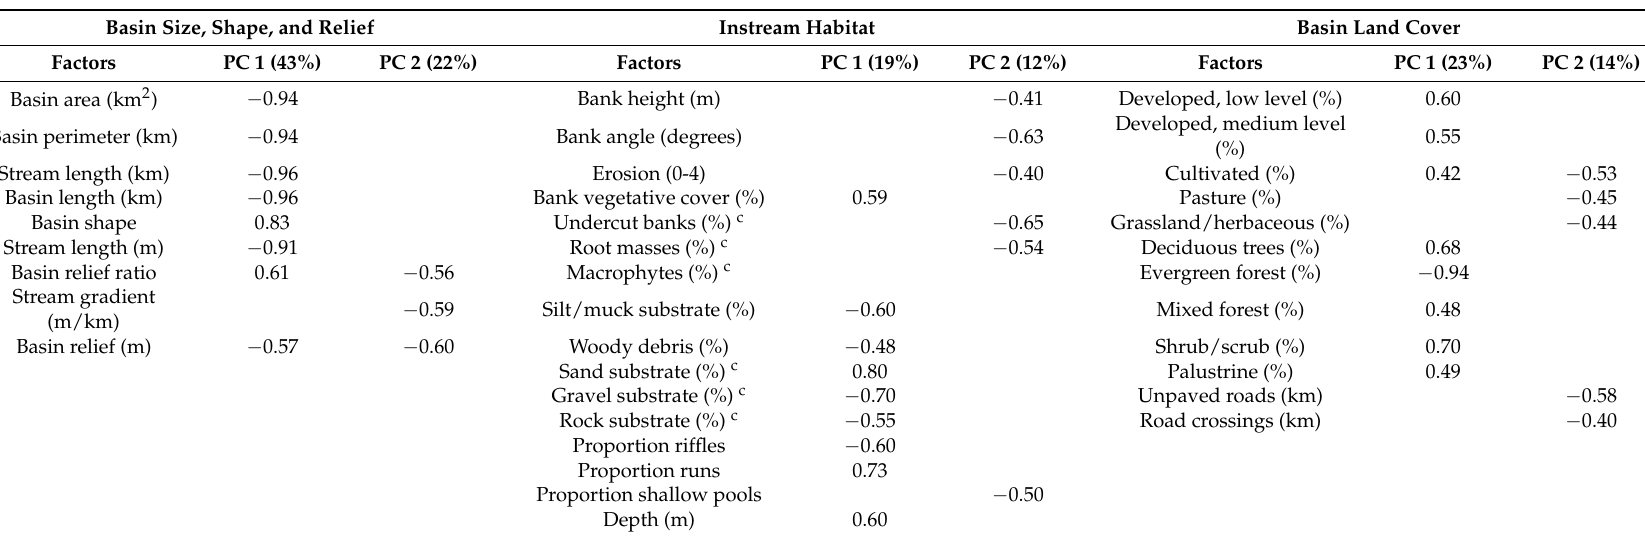
Table 6. Variable loadings (Pearson r) on axes 1 and 2 of three Principal Components Analyses of sample sites based on (1) variables representing, basin size, shape, and relief, (2) instream habitat variables, and (3) land cover variables. Only variables with Pearson r values > 0.4 are